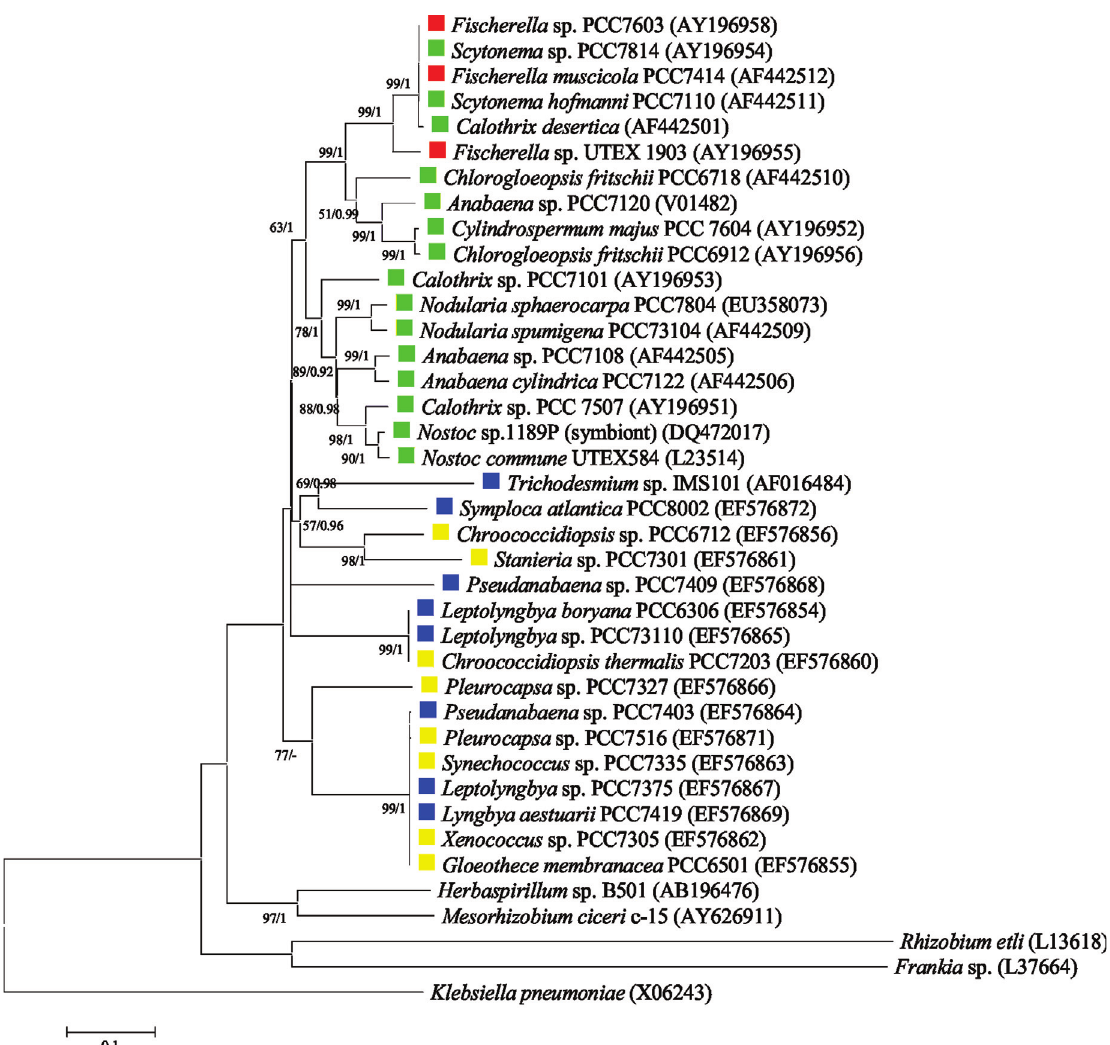
Figure3 -MaximumLikelihood(ML)phylogeneticreconstructionbasedonpartial nif Dgenesequences.Atotalof39nucleotidesequencesof (cid:2) -subunit of dinitrogenase were used. A matrix with 6,904 base pair lenght was obtained after alingment. The general time reversible evolutionary model of substi- tution with gamma distribution and with an estimate of proportion of invariable sites (GTR + G + I) was selected as the fittest for the alignment by MrModelTest 2.3 (Nylander, 2004). Phylogenetic trees were reconstructed using the ML and Bayesian methods. For Bayesian analysis, the trees were searched using the software MrBayes 3.2.6 (Ronquist et al. , 2012) and the Bayesian analysis consisted of two independent runs, with four Markov chains each, of 50 million generations sampled every 5,000 generations. Posterior probabilities (PP) were calculated at the conclusion of the Markov- Chain-Monte-Carlo analysis and a traditional burn-in on the first 25% of the trees was performed. The ML trees were reconstructed using the MEGA pro- grampackage,version5(Tamura etal. ,2011).Therobustnessofthephylogenetictreeswasestimatedviabootstrapanalysisusing1,000replications.ML and Bayesian methods resulted in nearly identical topologies, with indications of bootstrap values (ML) and Bayesian PPs in the relevant nodes.The cyanobacterial morphologies are highlighted with different colours: yellow for unicellular strains, blue for filamentous non-heterocytous strains, green for filamentous heterocytous strains without branching, and red for filamentous heterocytous strains with true branching. Sequence data from this article can be found in the NCBI database under the accession numbers, which are presented together with the strain